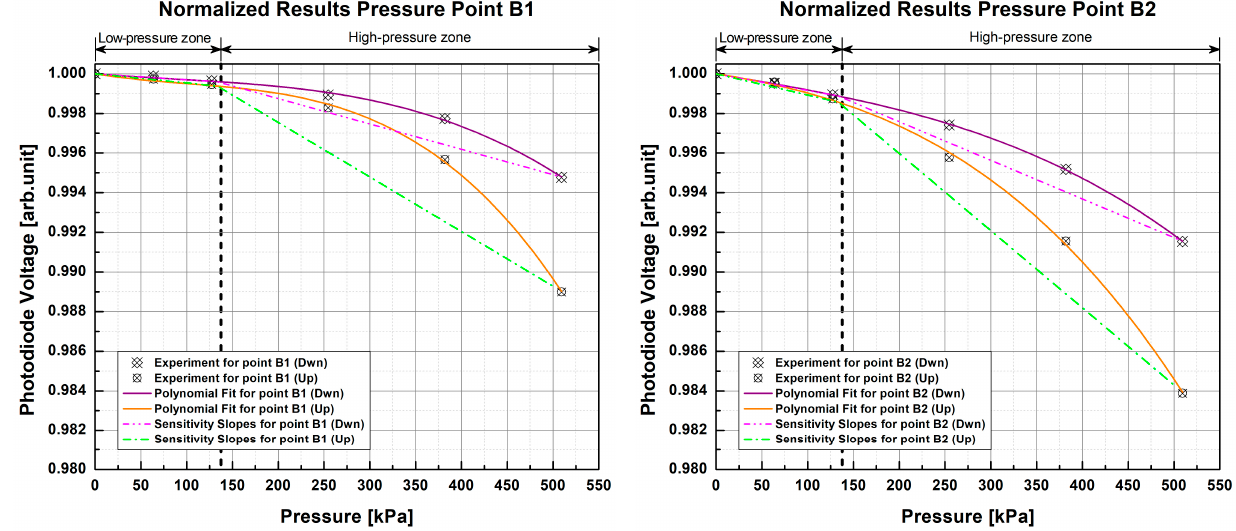
Figure 8. Normalized response curves of the 2 POFs × 2 POFs sample with the scientific ‐ grade equipment setup at different pressure points. The experimental data points correspond to the average of two test repetitions.